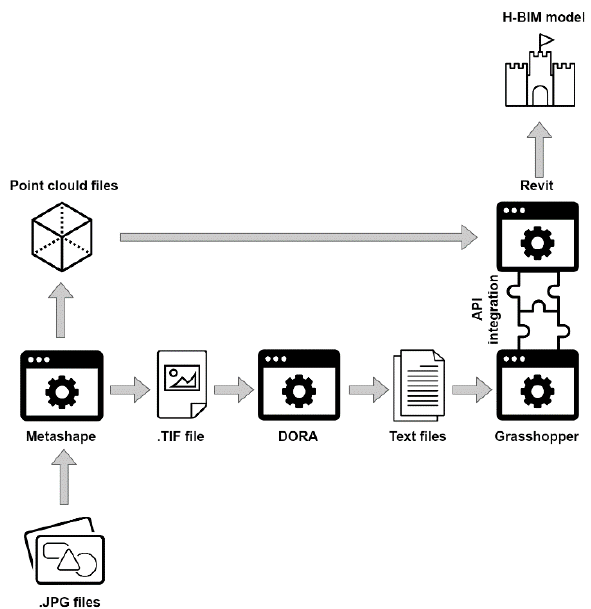
Figure 5 . Scheme of DECAI general workflow, highlighting the data flows from survey to H-BIM environment.